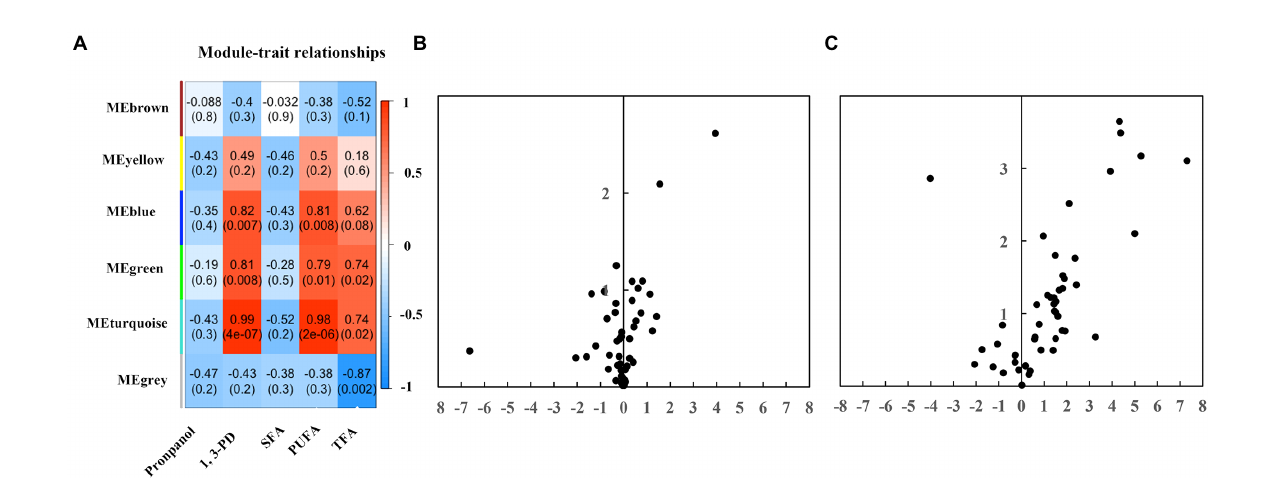
FIGURE 4 The GC–MS metabolomic profiling. (A) The heatmaps. The numbers within the heat map represent correlations and p -values for the module-trait associations. (B) A volcano plot analysis of the metabolic profile of propanol. (C) A volcano plot analysis of the metabolic profile of